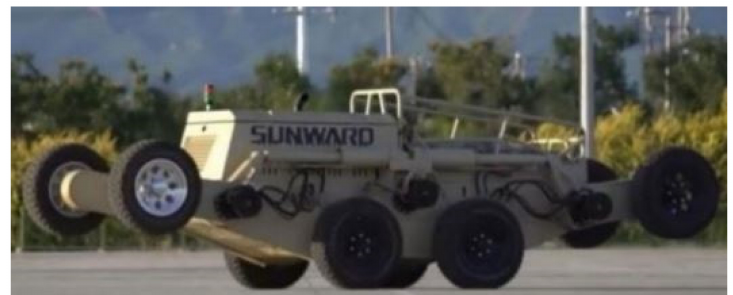
Figure 5. An 8 wheel, 4 arm unmanned ground